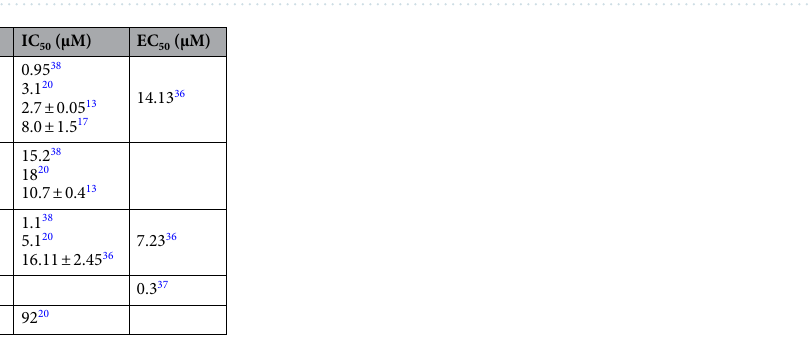
Table 1. K d , IC 50 , and EC 50 values for SARS-CoV-2 M pro -inhibitor complexes from inhouse and other studies. ND not determined. # This